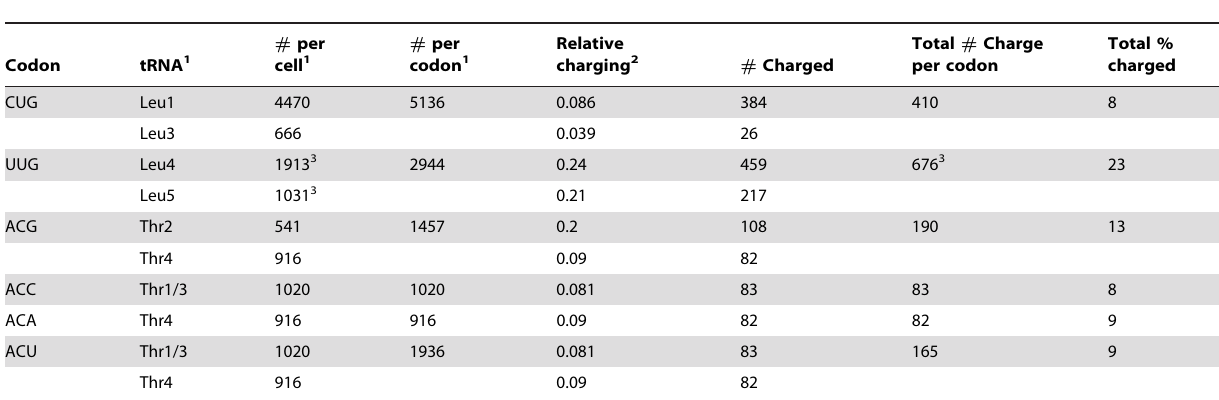
Table 3. Charging of leucine and threonine codons under starvation